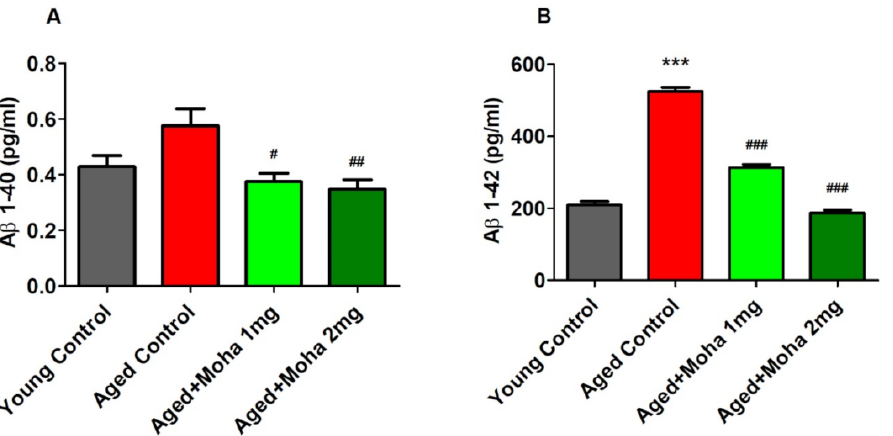
Figure 5. Effects of mahanimbine on the formation of β -amyloid (A β ) levels in aged mouse brain. ( A ) Comparison of the A β 1-40 level. ( B ) Comparison of the A β 1-42 level. Mahanimbine administration significantly reduced A β levels in aged mouse brains. All data were expressed as mean ± SEM ( n = 6). One-way ANOVA ( F (3,20) = 5.696, p < 0.01 for A β 1-40 level and F (3,20) = 50.50, p < 0.001 for A β 1-42 level) followed by Tukey–Kramer multiple comparisons test. *** p < 0.001 in comparison with young control; # p < 0.05, ## p < 0.01 and ### p < 0.001 in comparison with aged control.